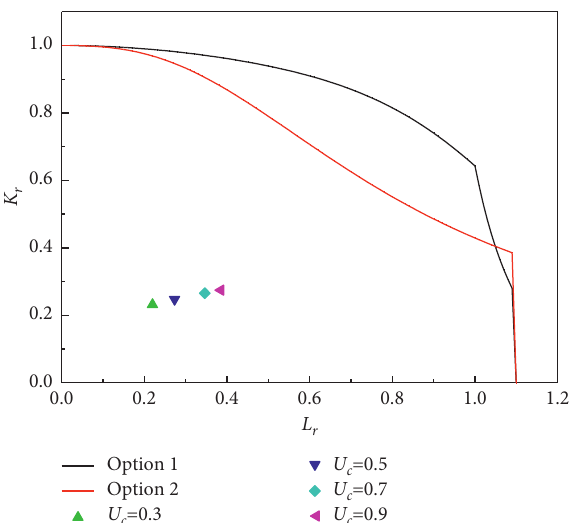
Figure 13: Effect of the reduced velocity on the fracture performance of the riser.